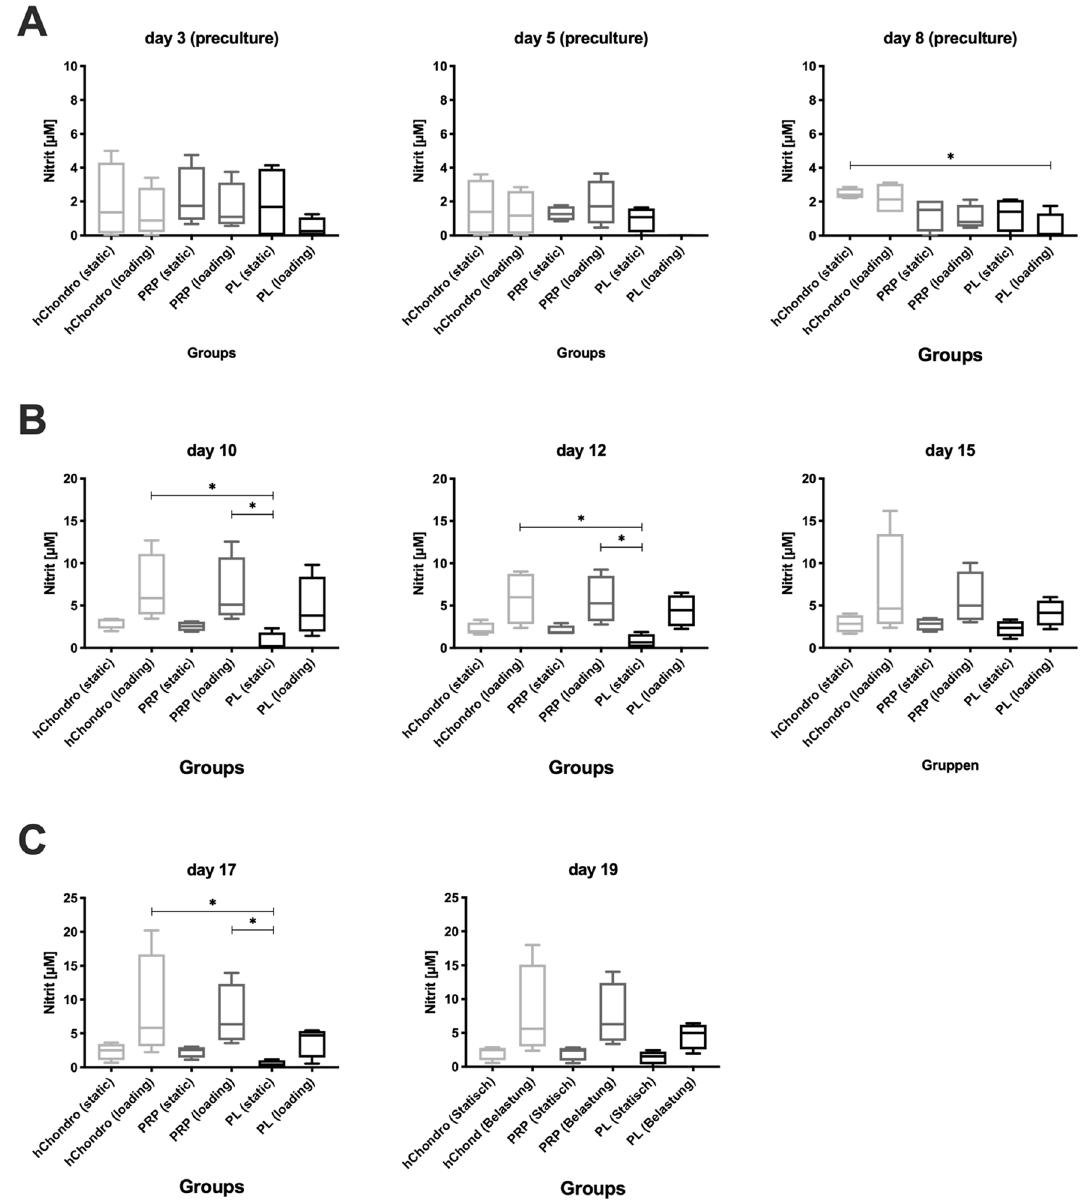
Figure 3. Quantitative measurement of nitrite over time under preculture ( A ), mechanical loading during the 1st week ( B ) and the 2nd week ( C ), * defines significance between specific groups p < COL2A1/COL10A1 (Fig. 5A) and COL2A1/COL1A1 ratios (Fig. 5B) were calculated to assess chondrocyte hypertrophy and dedifferentiation, respectively. An increased COL2A1/COL10A1 ratio was observed in loaded groups. ALK1 (Fig. 6A) showed a decreased expression with load, TGF-β receptor 1 (TGFBR1) showed an increased expression with load (Fig. 6B), while TGFBR2 was largely unaffected (Fig. 6C) . The ratio of ALK1 and TGFBR2 against TGFBR1 was calculated to estimate a relation of activated signaling cascades. ALK1/ TGFBR1 ratio sig- nificantly decreased under complex load, particularly in loaded PRP and PL groups, suggesting a shift towards TGFBR1 signaling (Fig. 6D). The TGFBR1/TGFBR2 increased with load and with supplementation (Fig. 6E), sug- gesting a shift towards Smad 2/3 signaling. In contrast, TGFB1 expression did only change with loading (Fig. 6F). TGF‑β1‑enzyme‑linked immunosorbent assay (ELISA). For an accurate assessment of TGF-β1 levels, active (A-C.2) and total (active and latent) (A-C.1) amounts were determined from pooled media samples of each week (Fig. 7). Striking was the amount of TGF-β1 measured in PL groups for week 1 (2661.40 ± 435.36 and 2891.44 ± 703.79 pg/ml) (B.1) and week 2 (2478.93 ± 476.26 and 2736.03 ± 953.70 pg/ml) (C.1). Both PL groups showed significantly higher activated TGF-β1 concentration than the control group (week 1 p = 0.0466 and week 2 p = 0.0370) (161.65 ± 116.89 in week 1 and 112.53 ± 97.51 pg/ml in week 2).